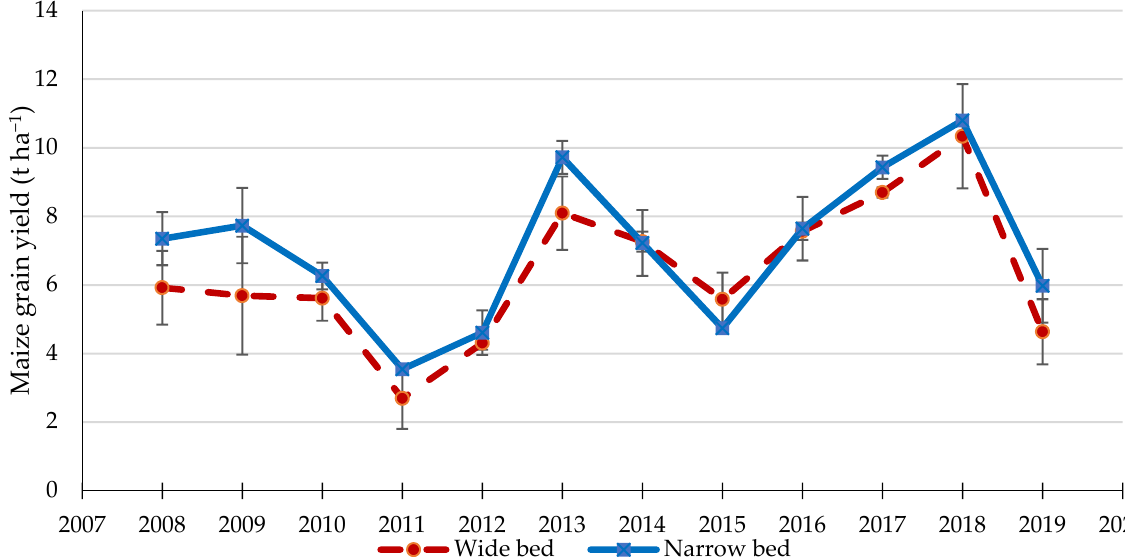
Figure 5. Maize yield with planting in wide and narrow beds in Texcoco II. Average yield for each year during the duration of the study; the error bars represent the standard deviation of the mean.